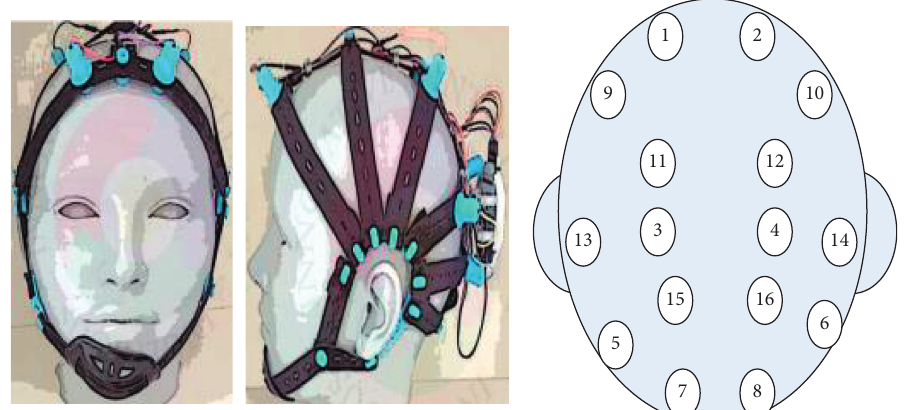
Figure 4: Electrode installation position of the electrode